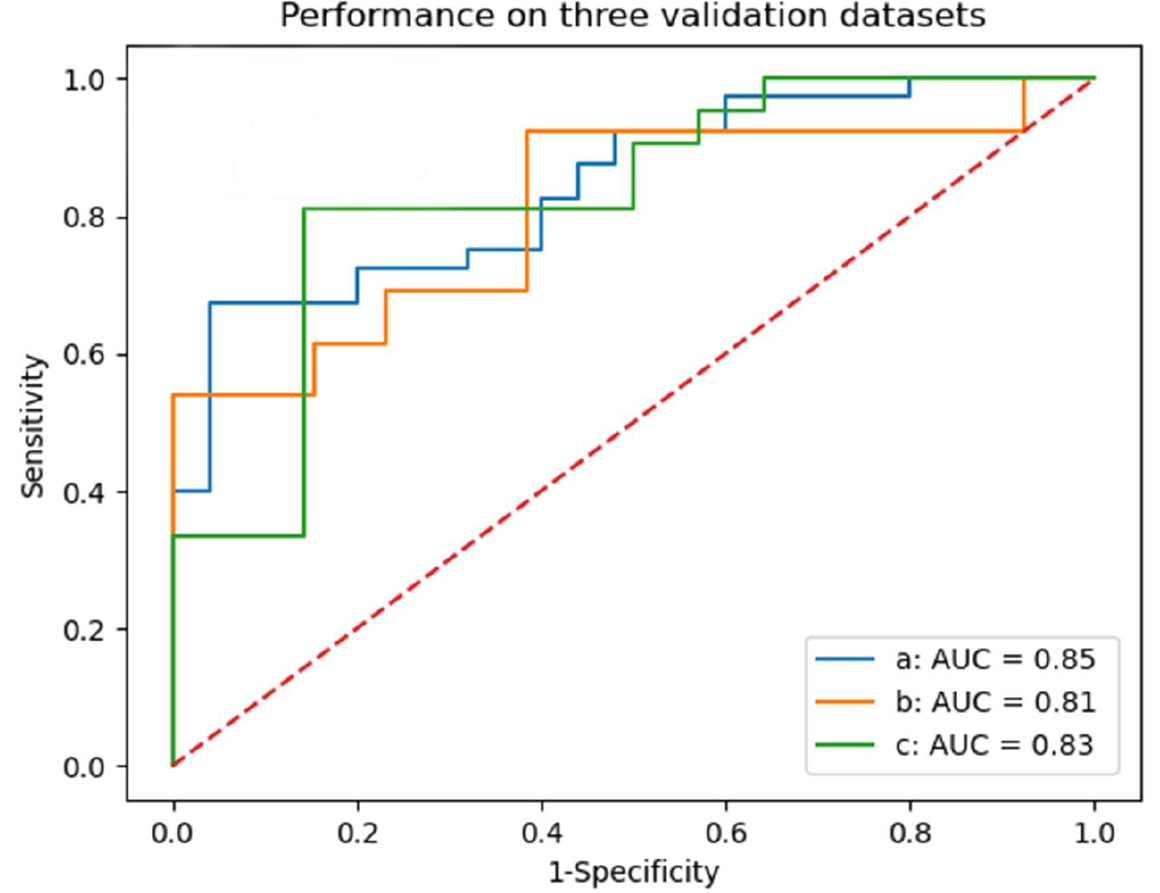
Table 4. Performance of logistic regression model in multicenter datasets.